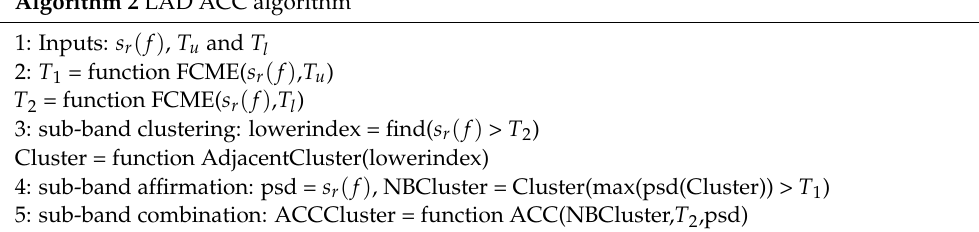
Algorithm 2 LAD ACC